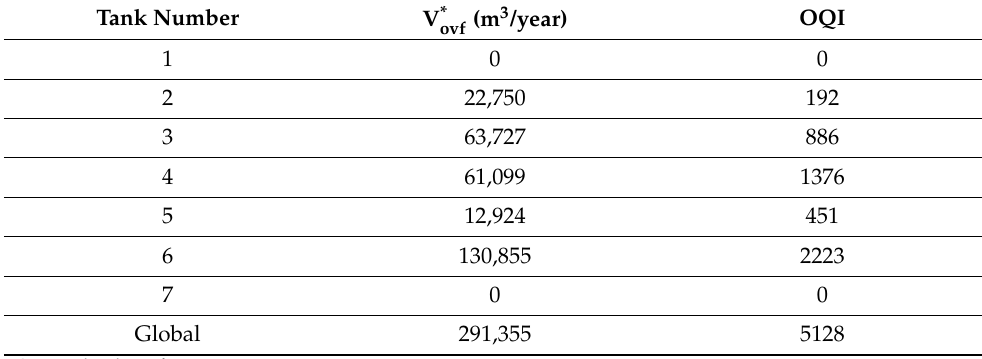
Table 7. Simulation results when the volume of overflow is minimized (Strategy #1).